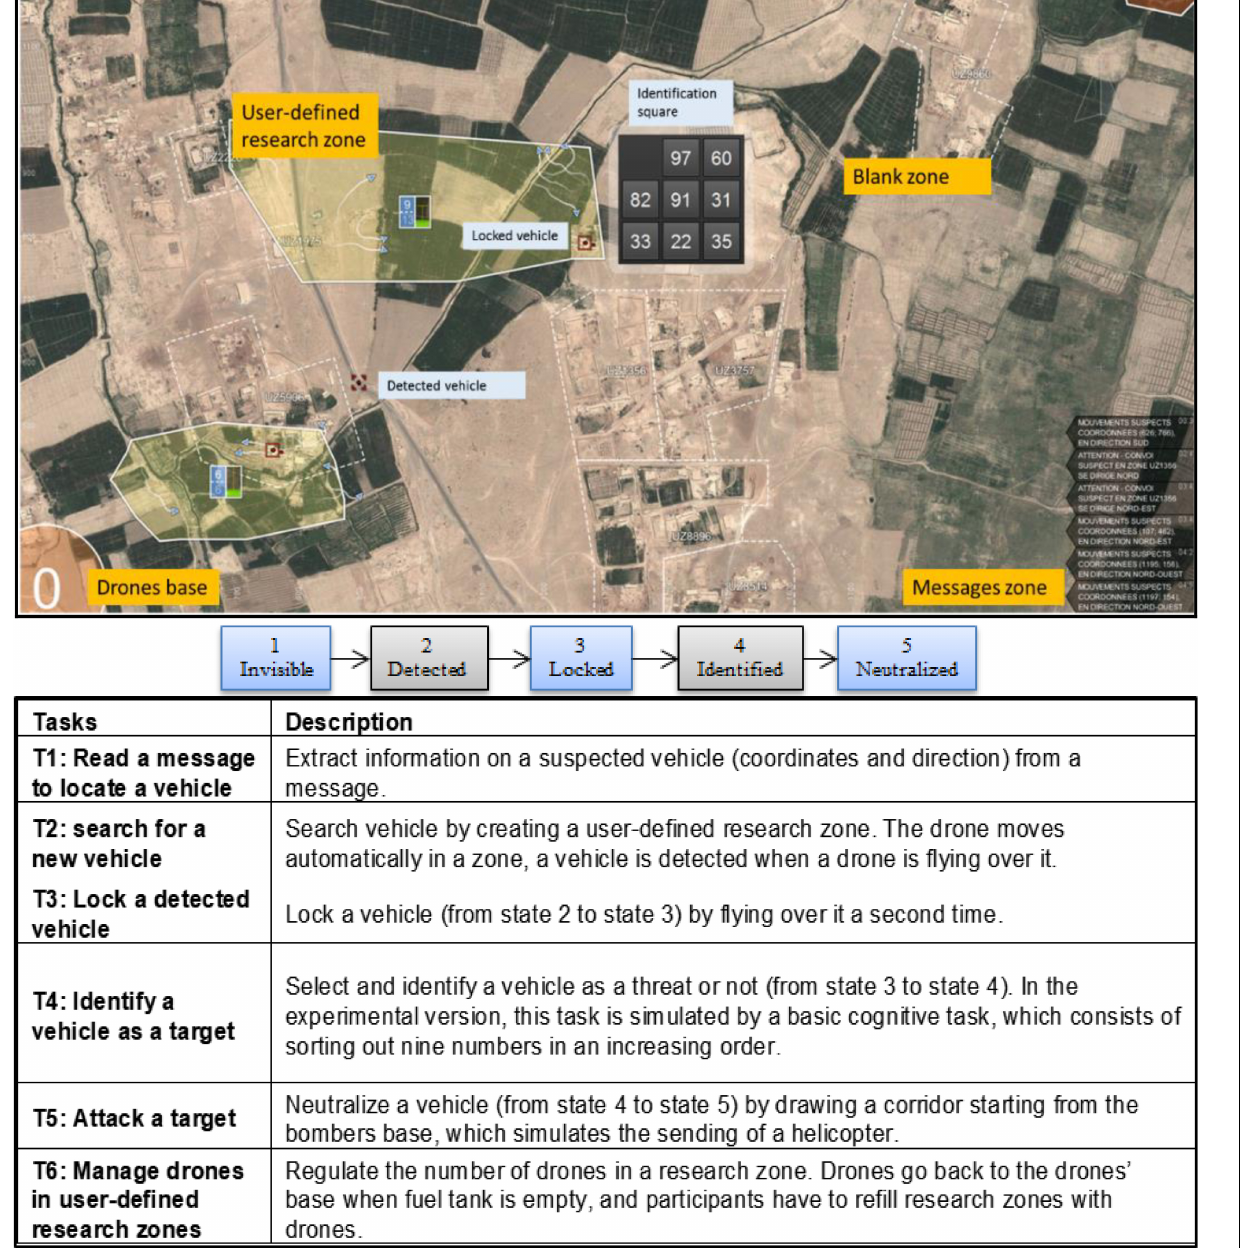
FIGURE 1 | SUSIE environment, sequential target states, and related tasks.